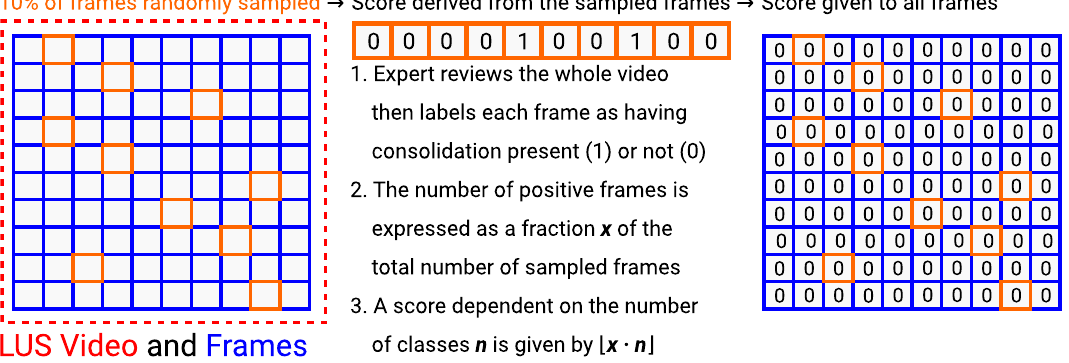
Figure 5. Illustrates the flowchart for the sampled binary and quaternary video-based labelling of consolidation/collapse frames as a percentage of the total number of frames for that video. For these sam- pled labelling methods, given an LUS video, 10% of its frames were randomly sampled rather than using peri- odic sampling to reduce systematic errors. In our case, the labels were from the frame-based labelling method (“Video-based labelling strategies” section) and were validated by the clinical experts (AW, MS) by assigning each frame a binary label of 0 (healthy) or 1 (unhealthy containing consolidation/collapse). After the 10% sampling of frames from an LUS video, all frames of the video were then assigned the same label depending on the proportion of unhealthy (consolidation/collapse) sampled frames, i.e. frames contain- ing signatures of pulmonary consolidation/collapse (Fig. 3). For the binary method, a label of 0 was given to all the frames in each video frames if less than half the sampled frames were unhealthy (consolidation/collapse). Otherwise, a label of 1 was given. For the quaternary method, on the other hand, if the proportion of unhealthy (consolidation/collapse) sampled frames was lower than 25%, a label of 0 was given. Labels of 1, 2 and 3 were assigned for a proportion less than 50%, a proportion less than 75% and for the remaining interval of 75%-100% inclusive, respectively.